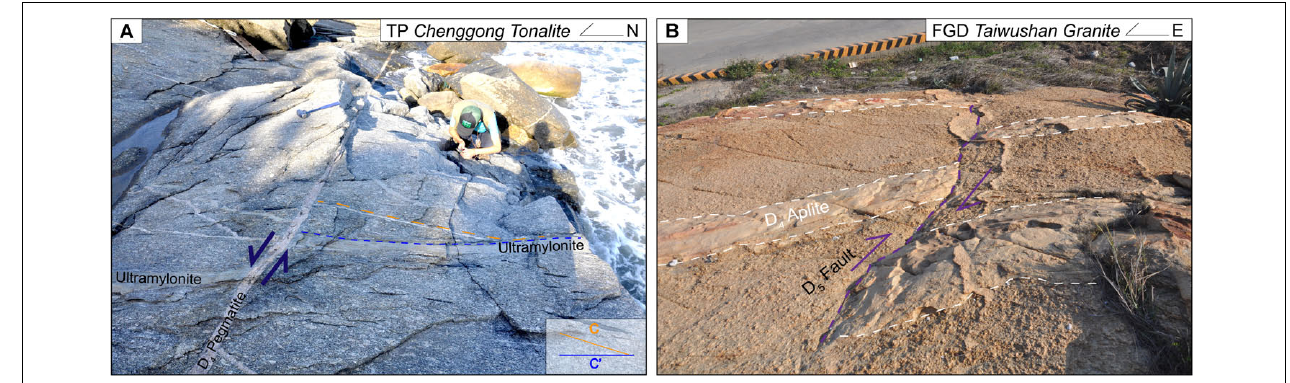
FIGURE 8 | Outcrop photos and sketches showing interpreted structures of D 4 and D 5 . (A) D 4 pegmatite sinistrally displaced the Chenggong Tonalite with C/C’ fabric, suggested by the displaced ultramylonite. (B) D 5 fault dextrally displaced the D 4